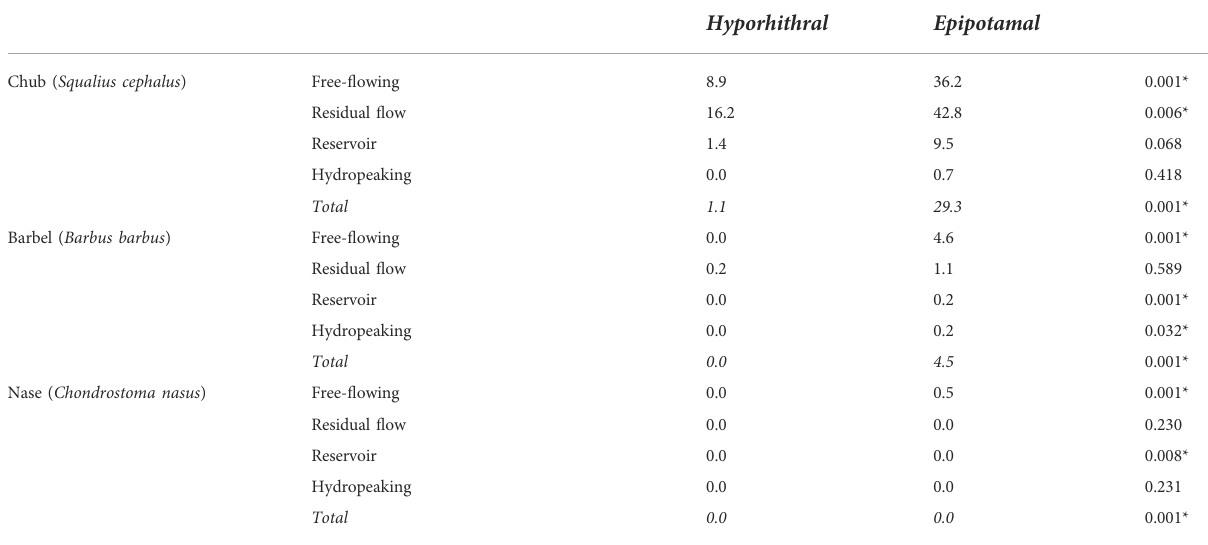
TABLE1Medianbiomassoftargetspeciesindifferenthydro-morphologicalcategoriesaccordingto fi shregion(hyporhithralandepipotamal),aswell as p -values of Median test assessing biomass differences between the fi sh